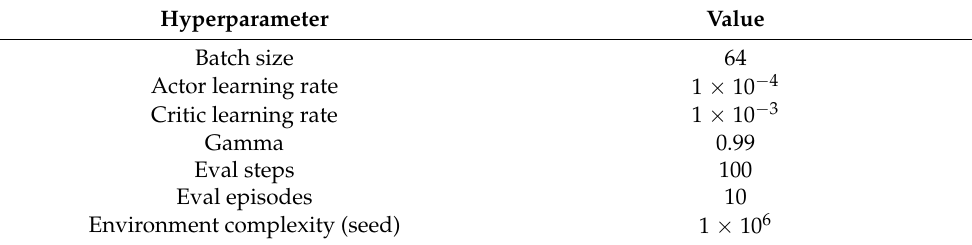
Table 3. Some parameters used in the implementation of the two frameworks.